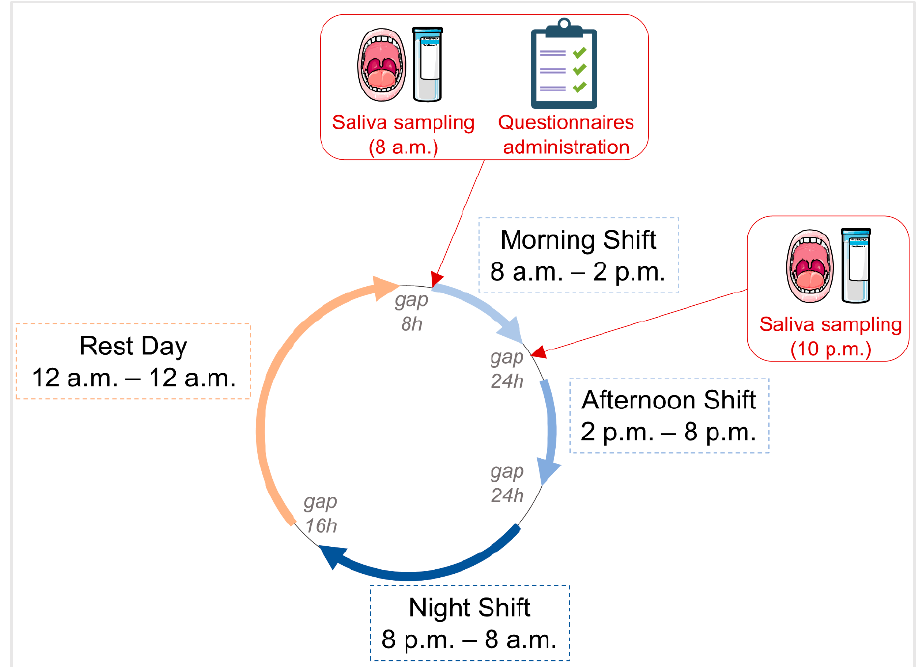
Figure 1. Shift schedule schematic and study procedure. Thick blue arrows represent clockwise work shifts (light blue, morning; medium blue, afternoon; dark blue, night); thick orange arrow represents the rest day. Gap lines between arrows represent non-working time. Red arrows show sampling timepoints during the procedure.